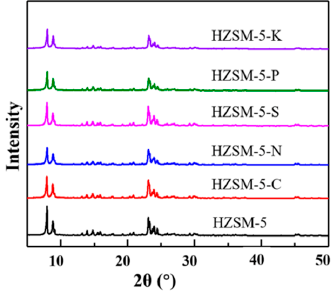
Figure 1. XRD patterns of the synthesized HZSM-5 zeolites. Table 1. Crystallinity of HZSM-5 synthesized with different additives.